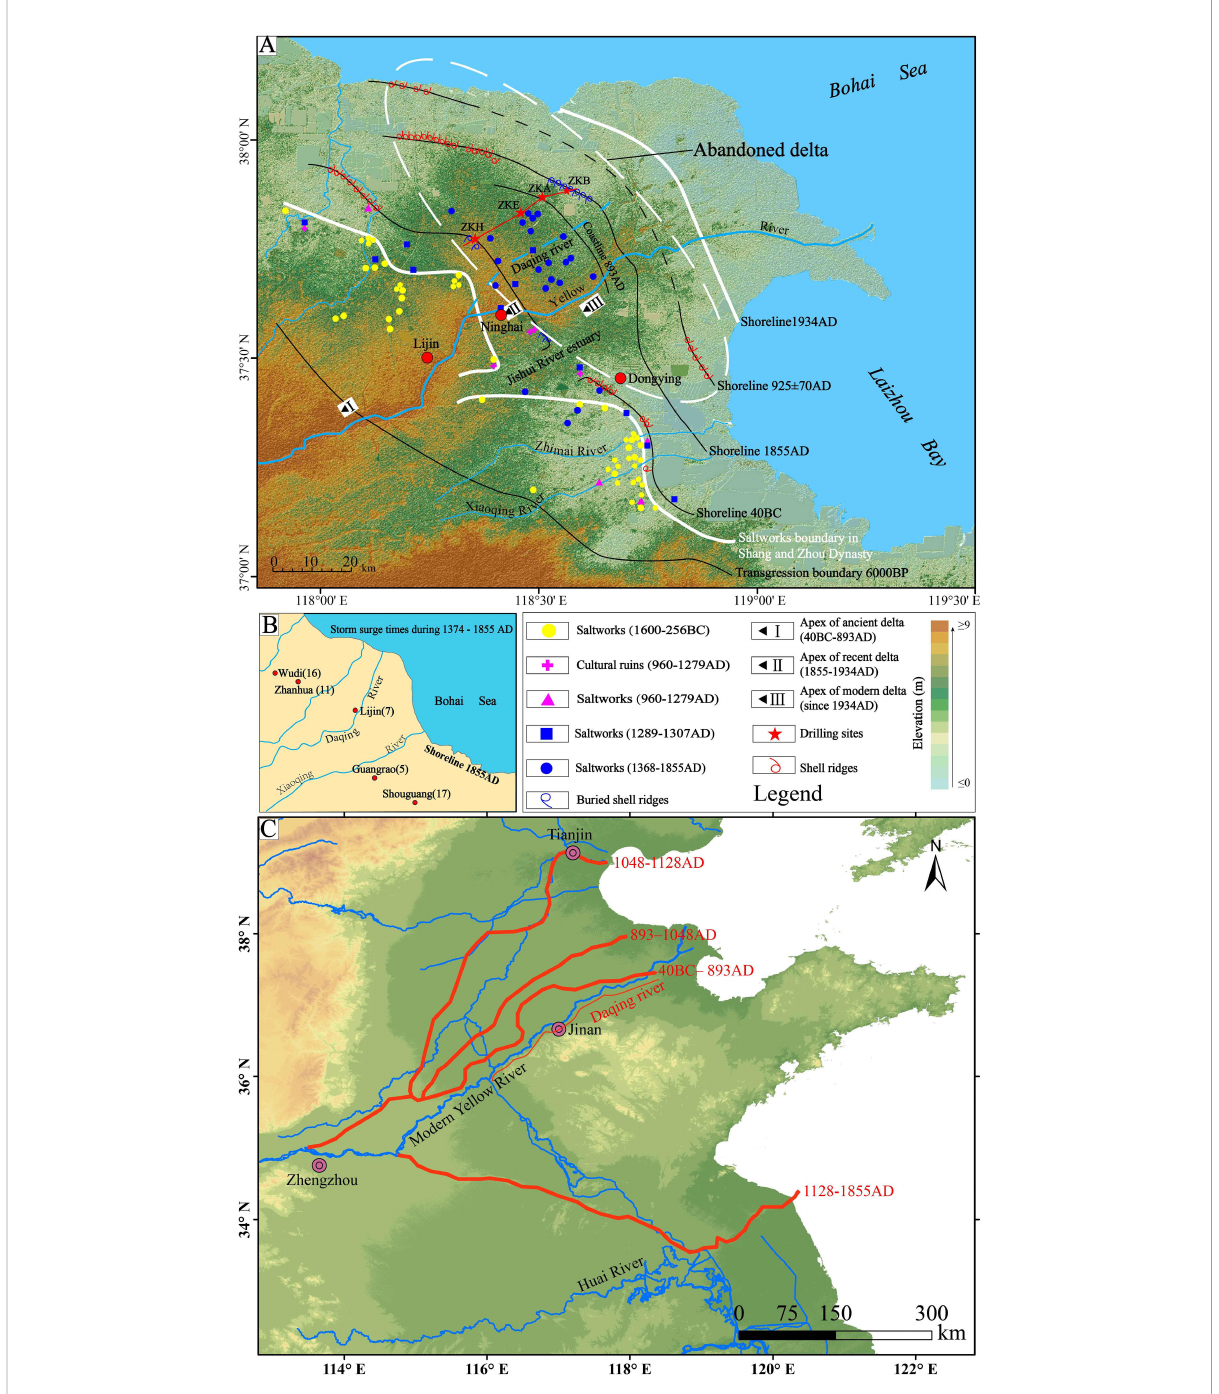
FIGURE 1 (A) Geomorphic features of the Yellow River delta, including the shallow-buried abandoned delta, the spatiotemporal distribution of the ancient coastline, and the location of the sampling sites. (B) Location of the fi ve cities during the Ming (1368 AD – 1644 AD) and Qing (1636 AD – 1912 AD) dynasties (Tan, 1975) and the number of storm surges during 1374 – 1855 AD (Wang, 2010). (C) The sketch map of changes in the course of the lower Yellow River during the last 2000 years (revised from Chen et al., 2012). Also shown are the distribution of ancient saltworks (Ji, 2009), with the coastal highlands on the inland side of the delta and more than 10 km away from the coastline in some